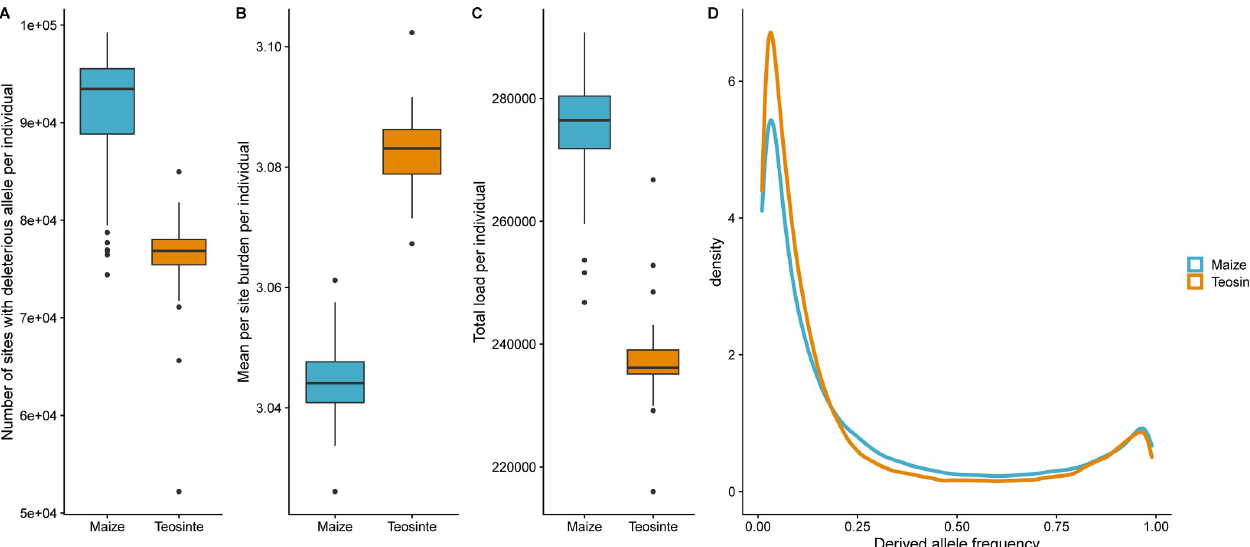
Fig 3. Predicted segregating mutational burden per parent in the parents of maize and teosinte populations. (A) Total number of sites heterozygous or homozygous for segregating deleterious alleles per individual parent, (B) Mean burden per site per parent based on genomic evolutionary rate profiling (GERP) score under a model of partial recessivity, including only sites segregating within the parent’s population, (C) Total burden per parent based on GERP scores, (D) Derived allele frequency spectrum for maize and teosinte populations. A total of 293,720 and 362,145 variants with GERP scores are segregating within maize and teosinte,